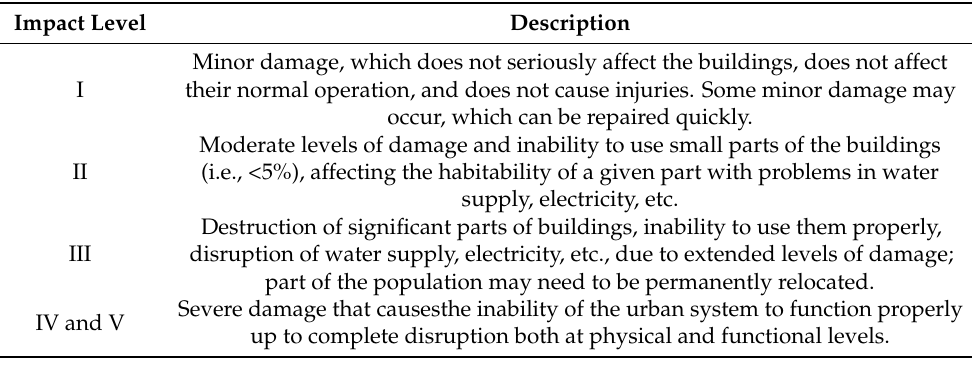
Table 1. Earthquake-related impact level description, modified by Mota de S á et al. [24].